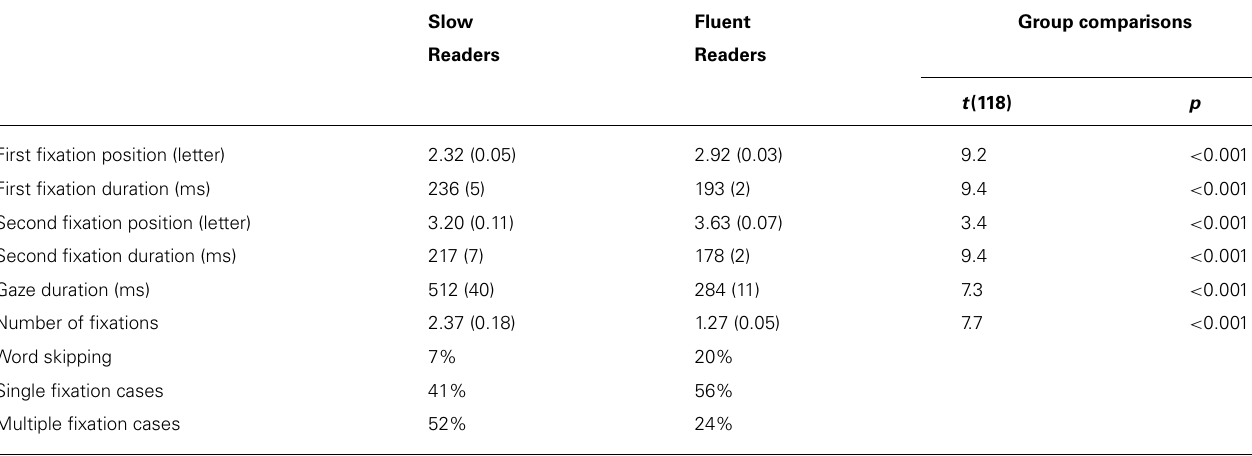
Table 1 | Means (standard errors) of global eye movement measures and group comparisons.